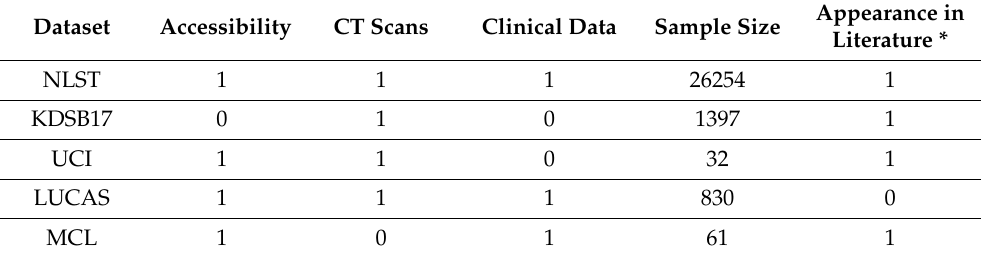
Table 3. Comparison of